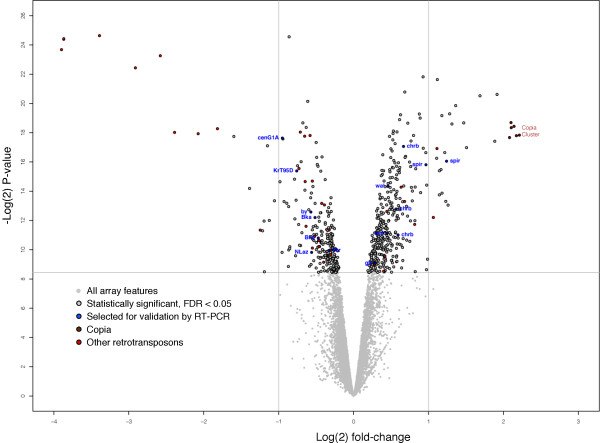
Distribution of effects on transcript accumulation in lola microarrays. Graphical representation of data from lola microarray experiment. Each gray dot represents the mean ratio of normalized feature hybridization for lola mutant/wild type from seven experiments, presented as a scatter plot of log2(adjusted P-value) versus log2(fold change) for each cDNA. Points above the horizontal line (circled in black) are statistically significant with the false discovery rate controlled to 0.05 (which, for this analysis, roughly corresponded to adjusted P < 0.0028). The six cDNAs corresponding to the copia retrotransposon are highlighted in brown; other retrotransposon transcripts are in red. Features corresponding to loci also quantified by quantitative RT-PCR are in blue. Note that different cDNAs corresponding to a single locus are plotted separately; thus, for example, there is a cluster of six, independent brown spots for copia.